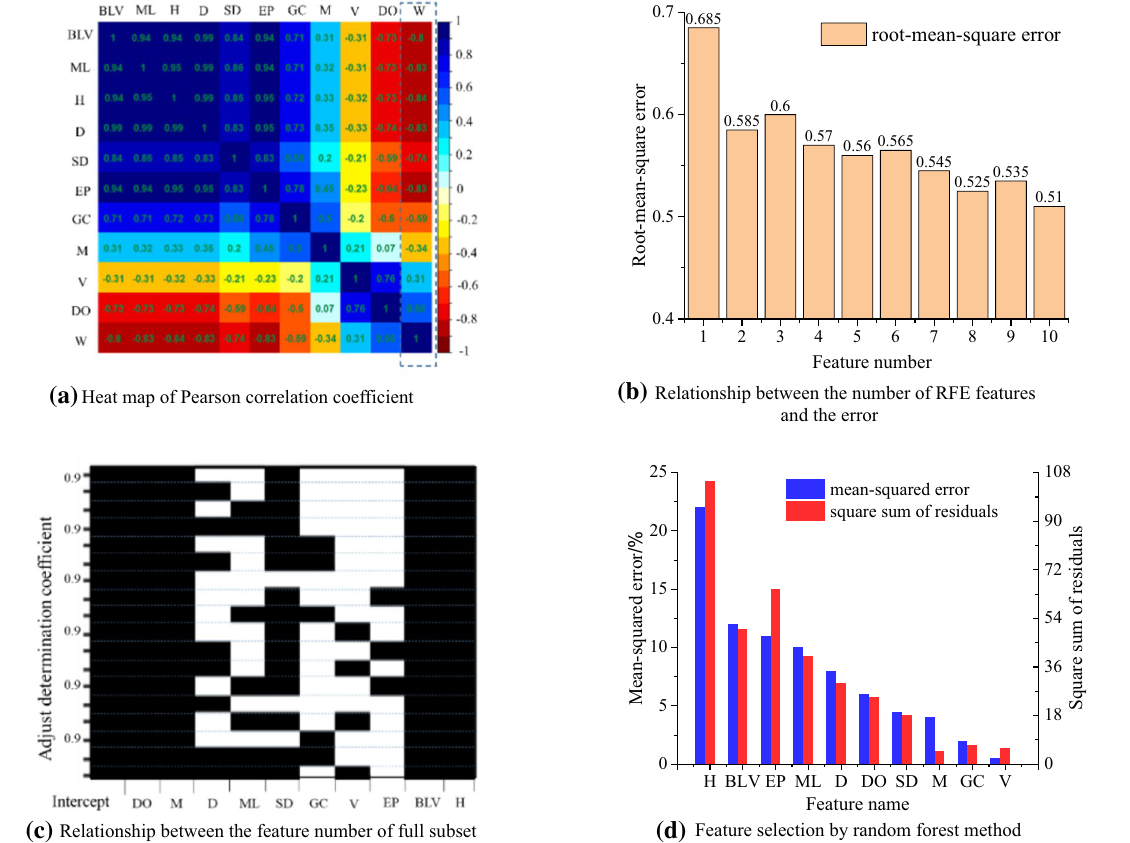
Fig. 3 Results of feature selection methods. Notes : The black box in c represents the selected parameter, and the blue dotted line represents the division of different parameter combinations, a total of 17